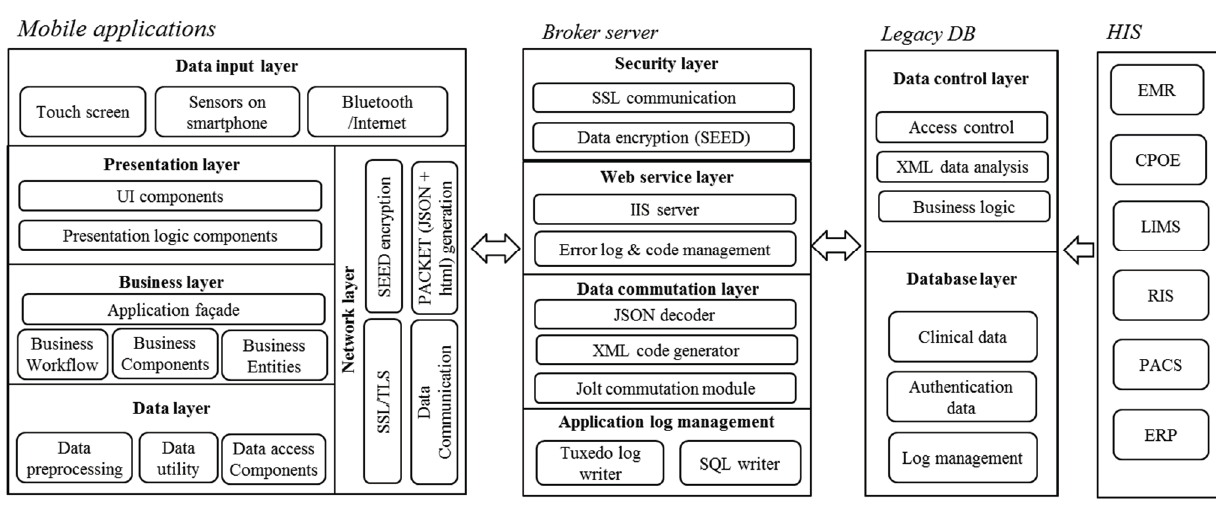
Figure 5. Technical architecture of mobile sensor applications. JSON: JavaScript